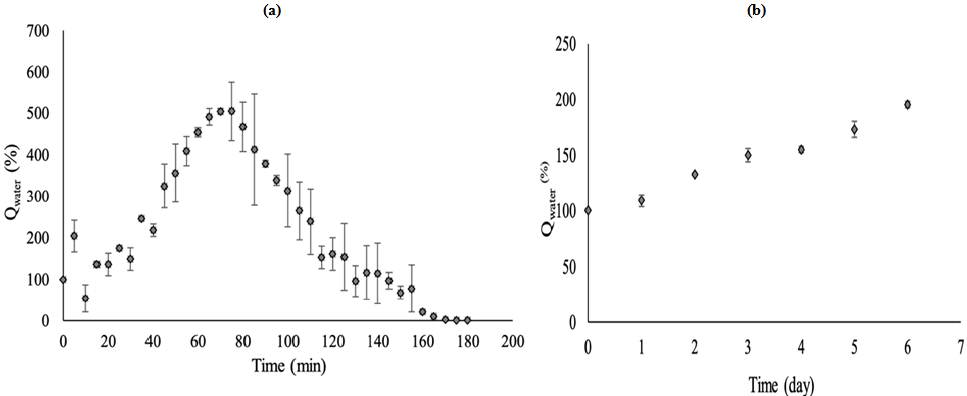
Figure 10. Difference in absorbency, Q water , of water versus time for ( a ) distilled water and ( b ) solid waste sludge.